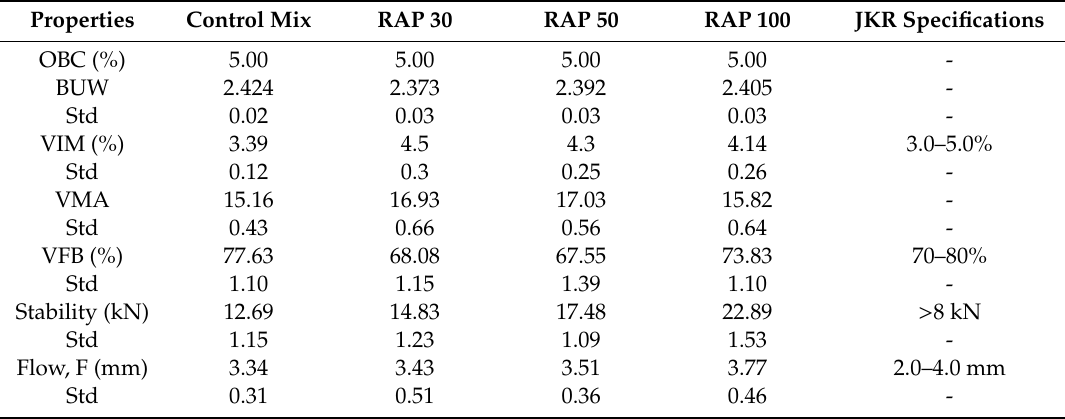
Table 5. Comparison of Marshall Properties of Control mix and RAP samples.